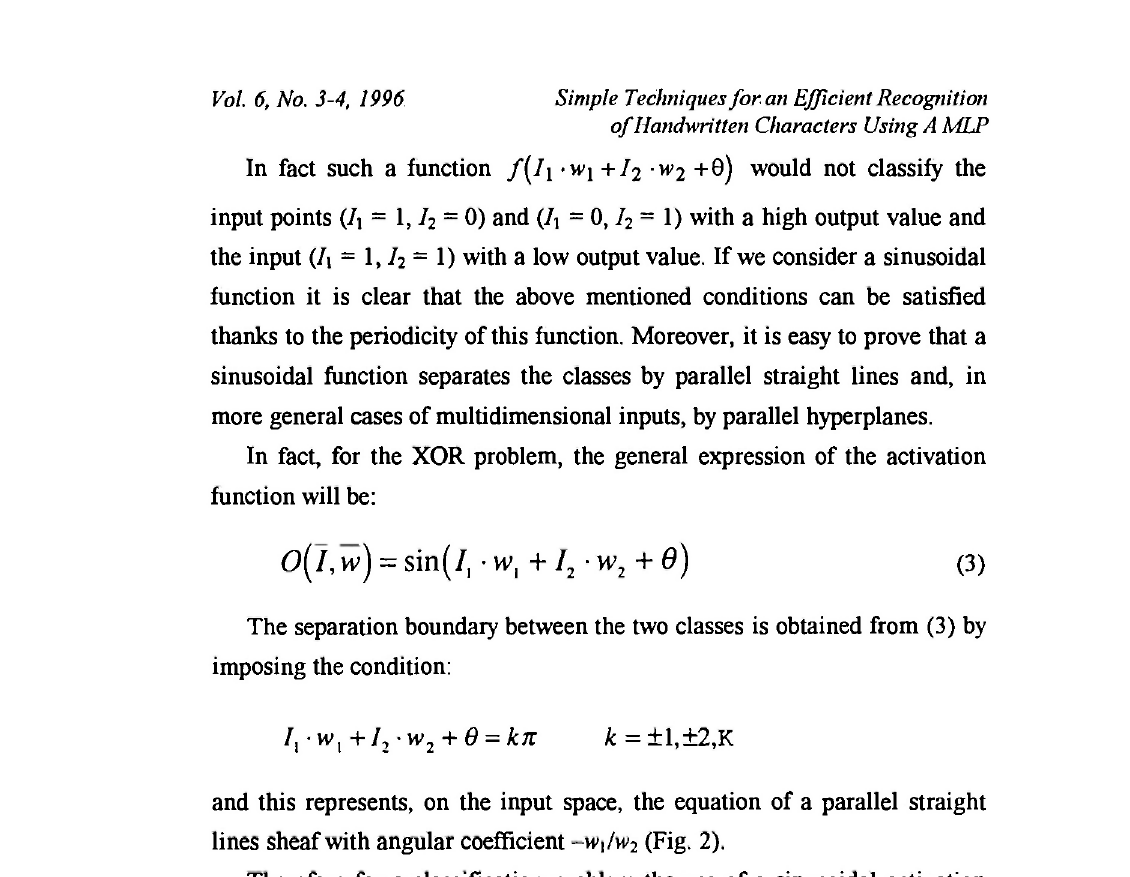
Fig. 2: (a) Perceptron employed for the XOR problem; (b) separation boundary of the two classes obtained using the sine